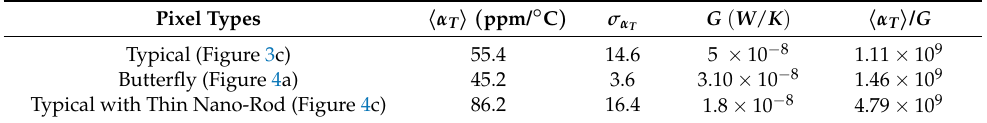
Table 3. Temperature coefficient of frequency (TCF) measured on different types of pixels: mean and standard deviation per wafer; thermal conductance of rods & legs G (computed from material properties and geometry measured by SEM).